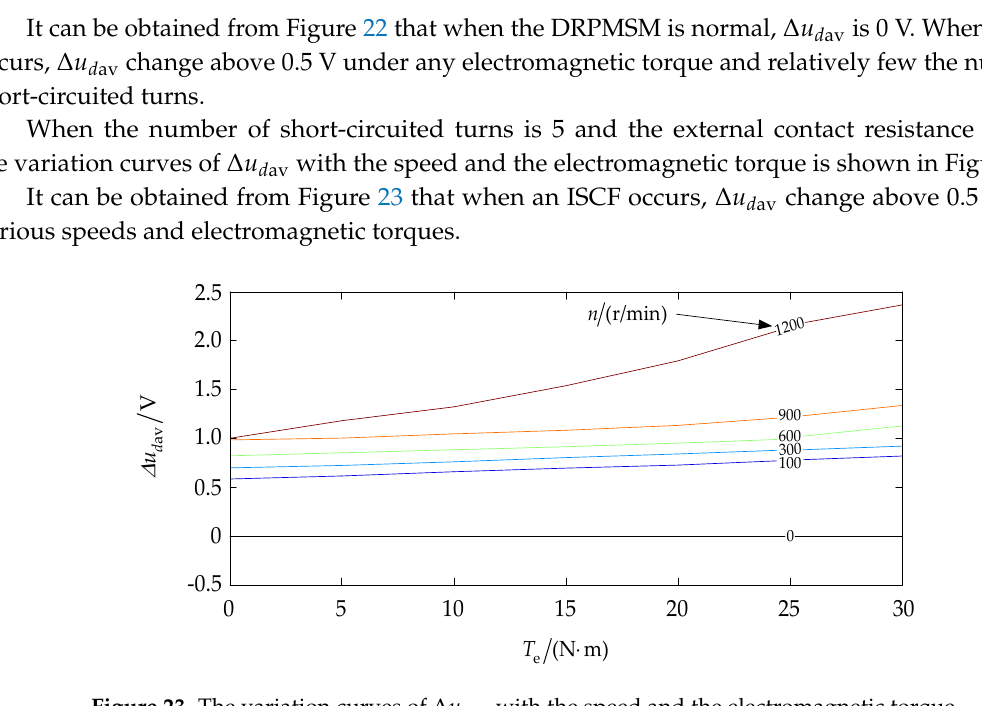
Figure 22. The variation curves of ∆ u d av with the number of short-circuited turns and the electromagnetic torque .